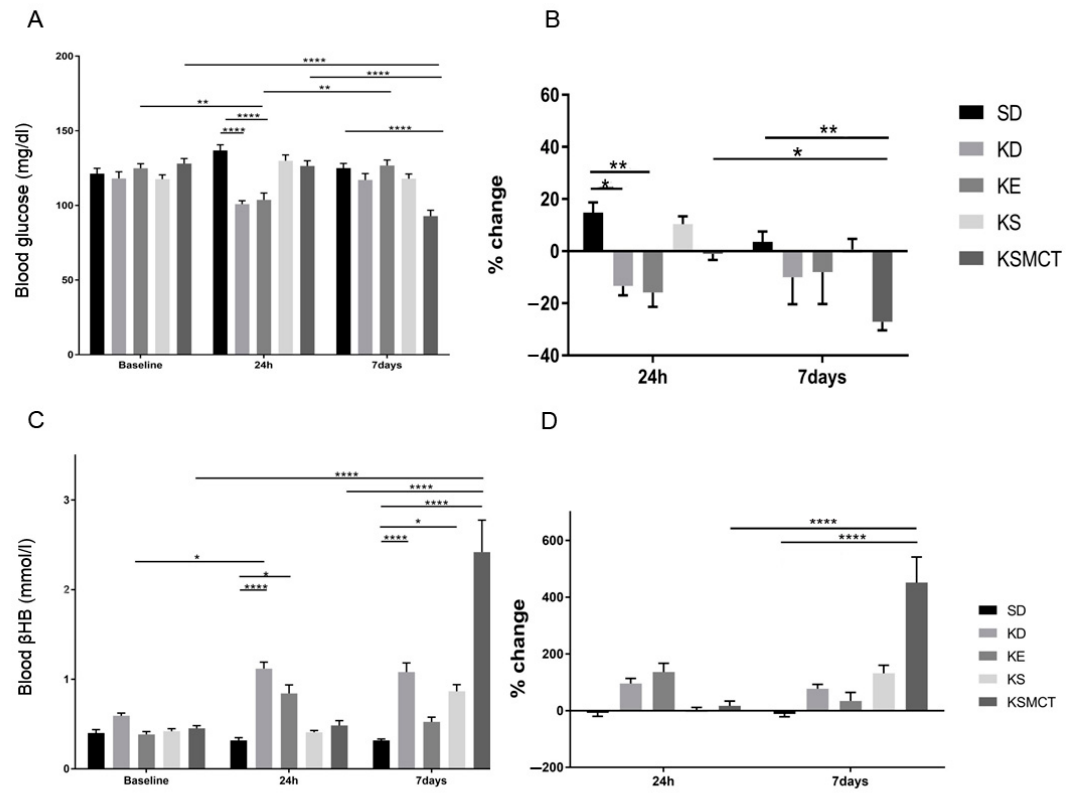
Figure 3. Changes in blood glucose and R - β HB levels of 4-months-old SPD rats after 24 h and seven days of treatment, in post-exercise state. ( A ) The change in glucose levels in SPD rats, with exercise, for the baseline, 24 h, and seven days post-intervention. ( B ) The corresponding percent change in glucose levels. ( C ) The resulting blood R - β HB levels. ( D ) The percent change in the blood R - β HB